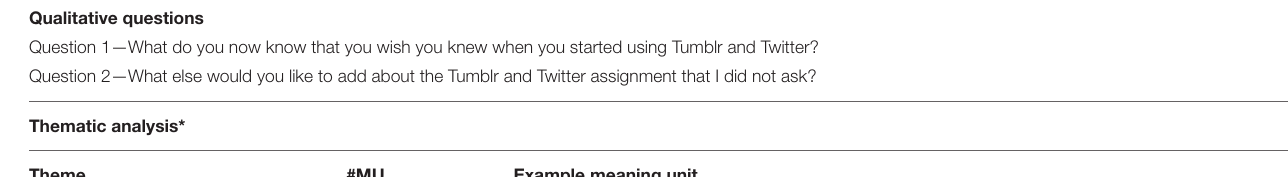
TABLE 2 | Qualitative questions and thematic analysis for a social media assignment used in community nutrition undergraduate course at Montana State University ( n = 50). Qualitative